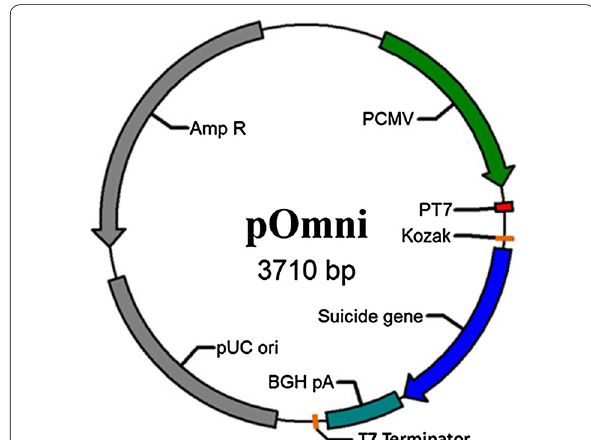
Fig. 1 Physical map of pOmni. Suicide gene (expression cassette of lysis gene E of bacteriophage Phi-X174) is to be replaced by cloned gene in PCRRC strategy so as to serve as positive selection gene for recombinant vector